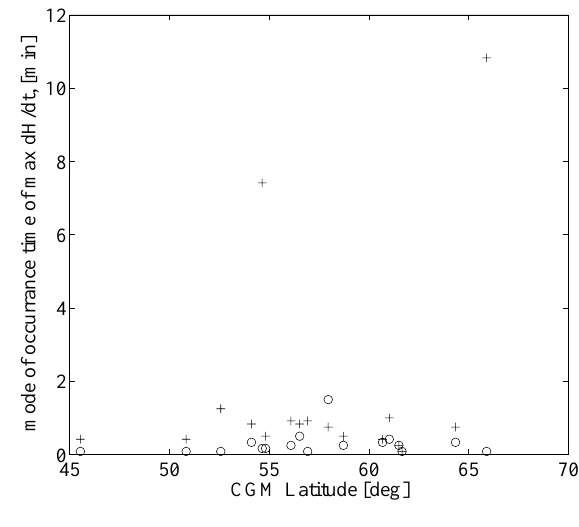
Fig. 5. Mode of occurrence of max | d H /dt | times against CGM latitude. Crosses are storm time substorm onsets (83 events), and the circles are non-storm time substorm onsets (470